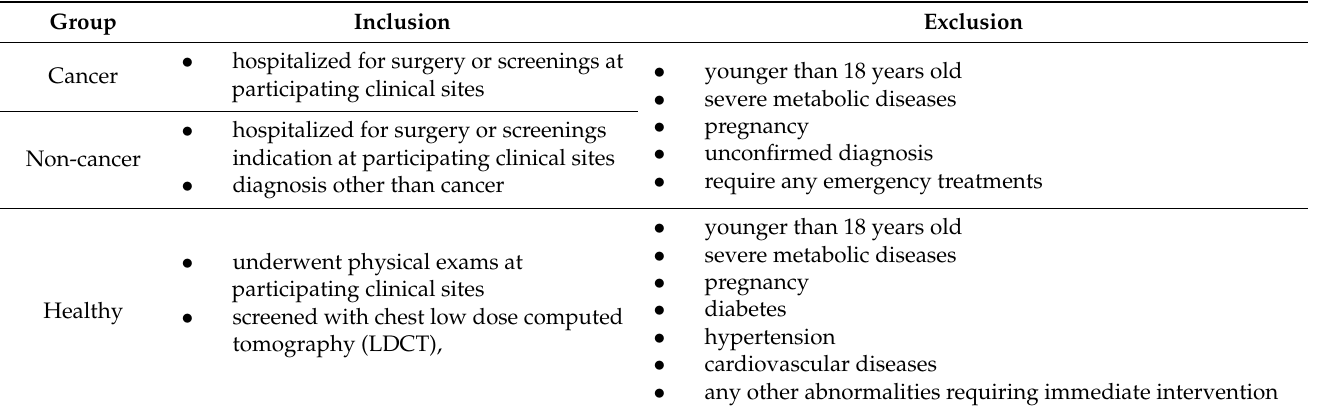
Table 1. Inclusion and exclusion